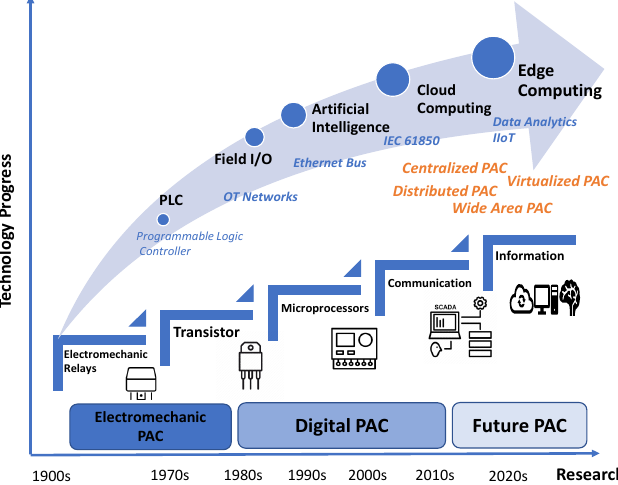
Figure 1. Evolution of PAC systems based on